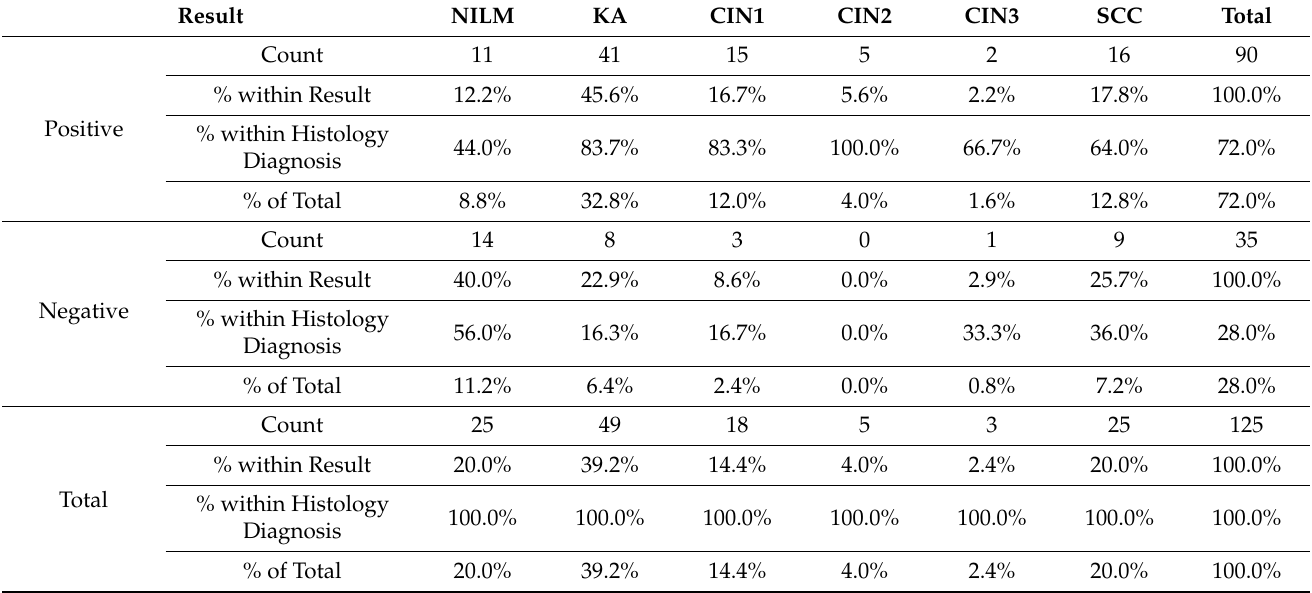
Table 1. Positive-negative HPV with histopathological morphology.